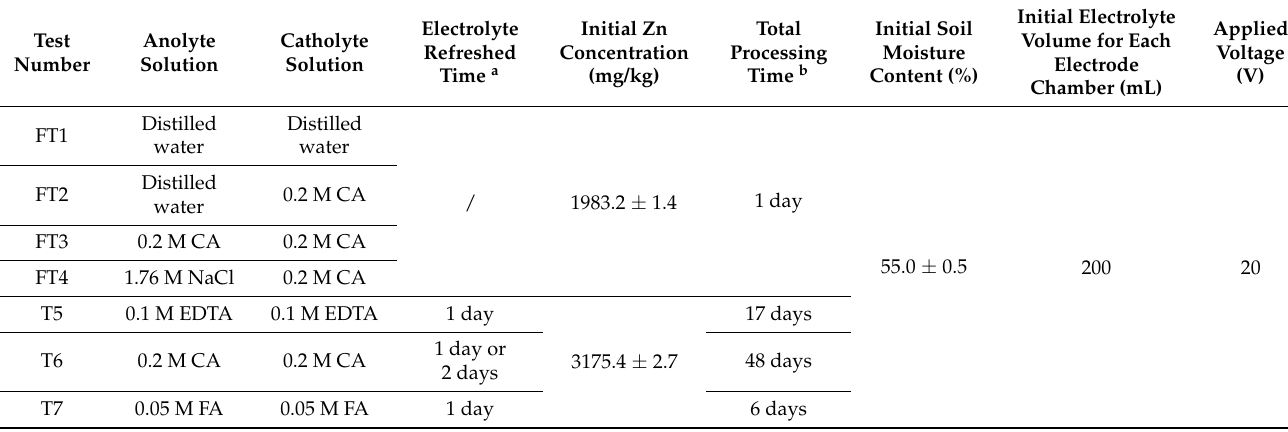
Table 2. Experimental scenario for EKR